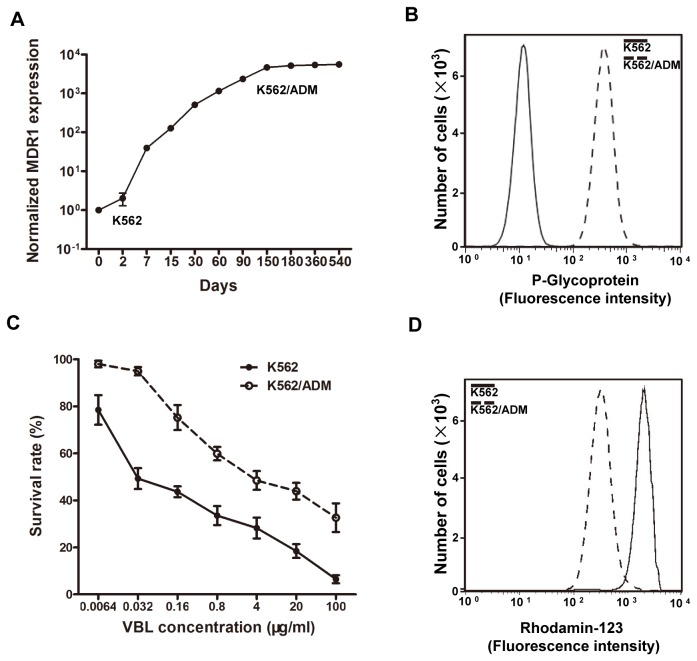
Generation of K562/ADM cells.(A) K562/ADM cells were established after exposure of K562 cells to ADM. MDR1 expression in parental and drug-treated K562 cells was normalized to the GAPDH housekeeping gene. (B) FACS analysis of K562 and K562/ADM cells stained with P-gp antibody. (C) MTT assay shows survival rate of K562 and K562/ADM cells under VBL treatment. The ratio of OD490 of VBL-treated cells versus control cells was used as the measure of survival rate. At least three independent experiments were performed and error bars represent standard deviation (S.D.). (D) FACS analysis of Rh123 accumulation in K562 and K562/ADM cells.